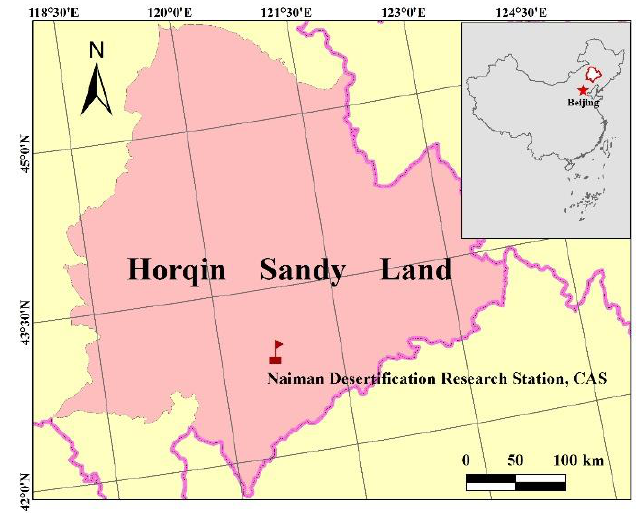
Figure 1. Location of the study area.